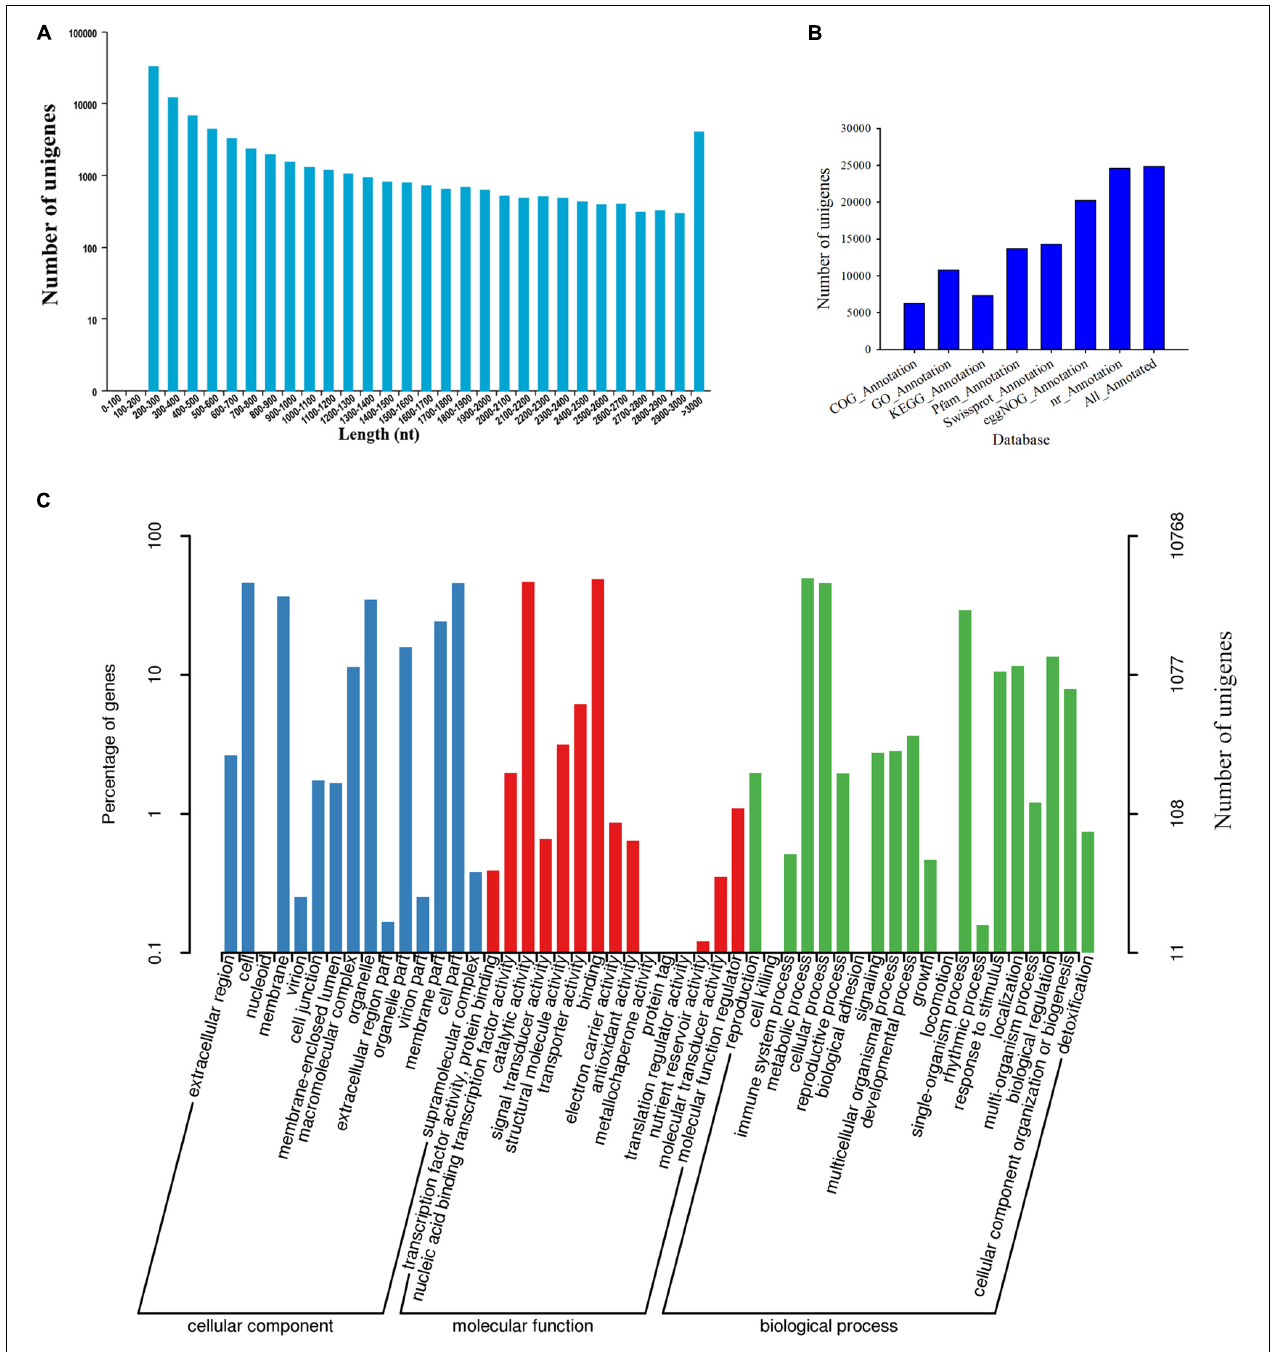
FIGURE 1 | Information of de novo assembled unigenes in C . sinense gleaned from transcriptomic analysis. (A) Length distribution of de novo assembled unigenes. (B) Annotation of unigenes against seven public databases (COG, GO, KEGG, Pfam, Swissprot, eggNOG, and nr). (C) GO functional classification (three subcategories) of the unigenes. The left Y-axis refers to the percentage of a specific category of target genes in that main category, while the right Y-axis refers to the number of target genes expressed in each